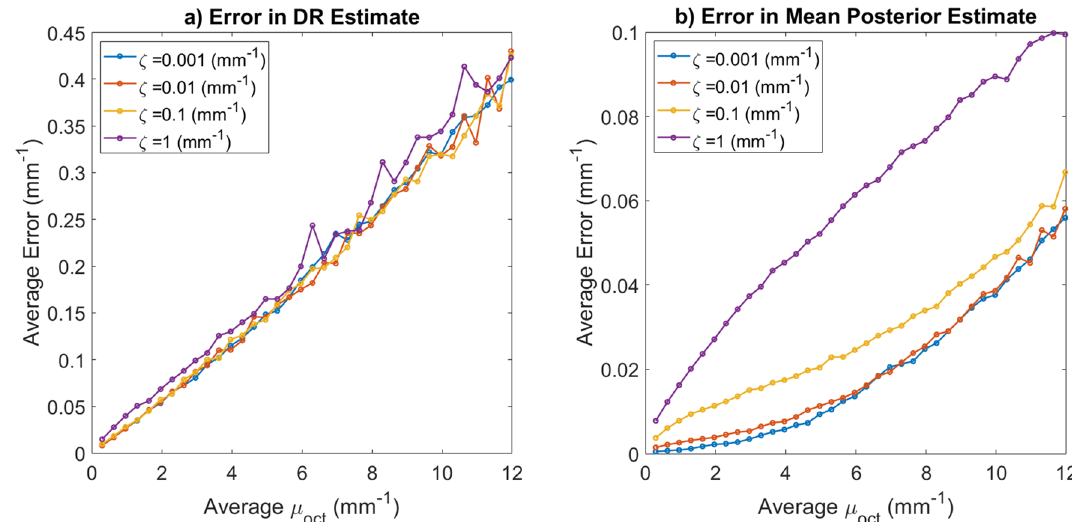
Figure 6. This figure demonstrates how problem parameters impact the error in the attenuation coefficient recovery. For each data point a single A-scan was simulated with 2000 depth measurements. After making the initial DR estimate, the deepest 30% of the pixels were discarded to avoid artifacts. The error (L2) estimates were made for each of the 1400 remaining pixels and averaged. Both the simulations and figure creation were done in Matlab 2019a 27 , https ://www.mathw orks.com/. ( a ) This image shows how the DR reconstruction error varies with different mean attenuation coefficients for a variety of ζ values. The ζ value does not appear to greatly impact DR Reconstruction fidelity. ( b ) This image shows how the mean posterior estimator error varies with different mean attenuation coefficients for a variety of ζ values. This estimate was computed using Eq. (26). Clearly, the incorporation of of this value into the prior impacts our uncertainty in our Bayesian